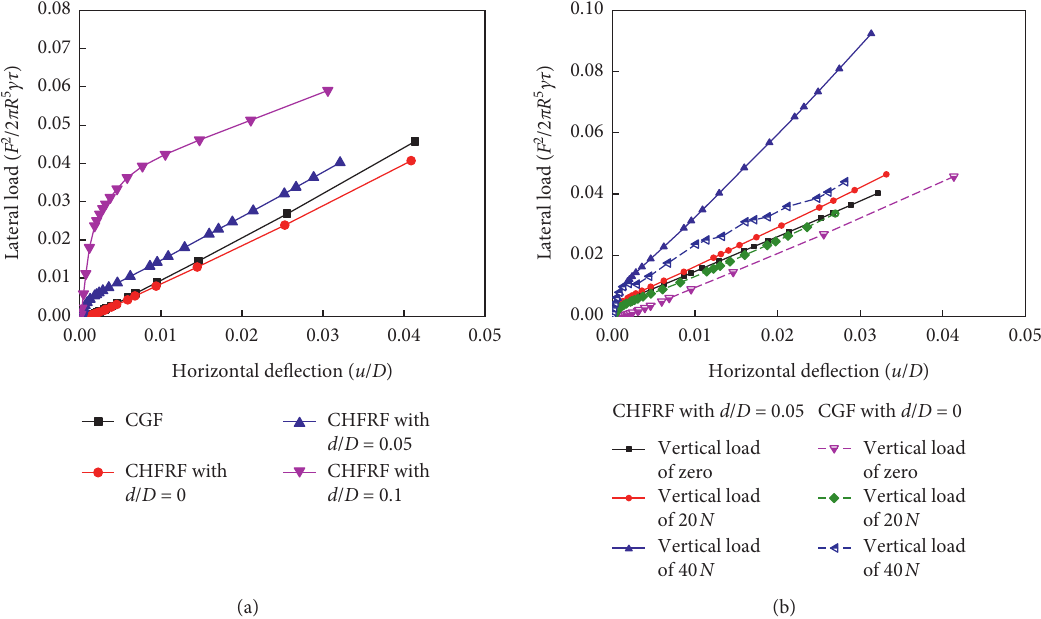
Figure 7: Effects of embedded depth on the lateral bearing capacity. (a) Vertical load of zero. (b) Vertical load range from 20N to